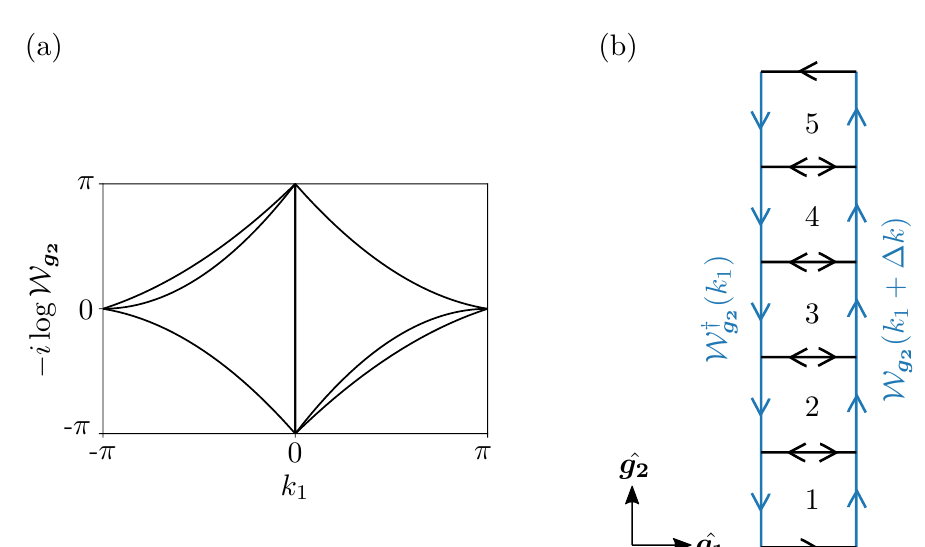
Figure 11: a) Wilson loop spectrum for a system with Chern number ν = 1. b) In + ∆ k . Taking the logarithm of the de- blue, Wilson loops along g at k and k 1 1 2 terminant in Eq. (133) allows us to close the path in the border of the BZ and apply Stokes theorem, to relate the Wilson loop spectrum to the Chern number. Horizontal segments do not contribute to the